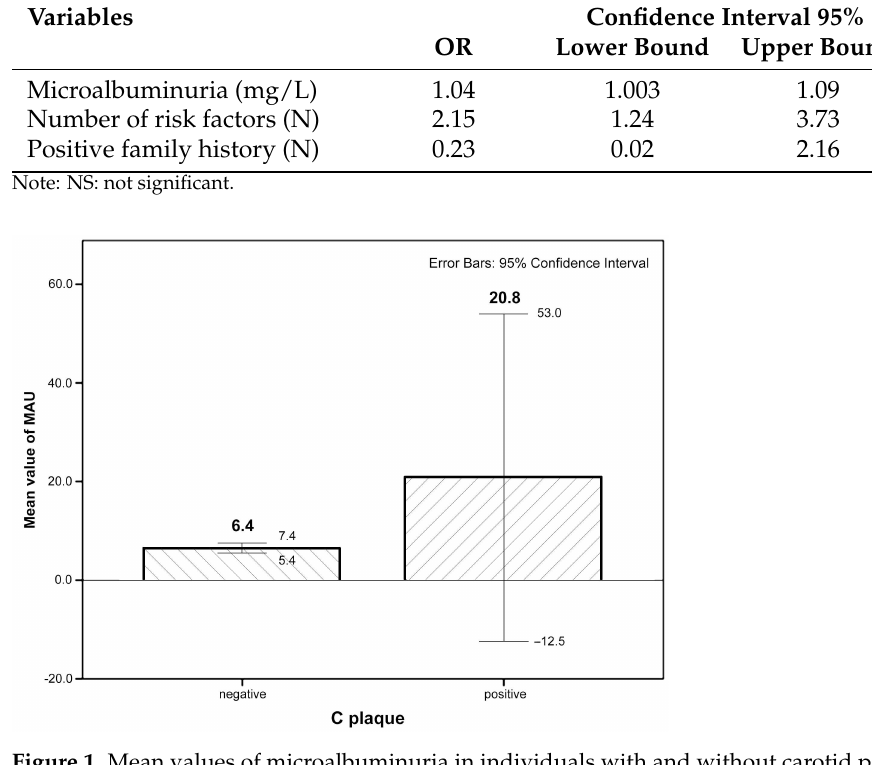
Figure 1. Mean values of microalbuminuria in individuals with and without carotid plaque. Note: data are shown as mean values of microalbuminuria (in mg/L) ± standard deviation; 95% confidence interval for individuals with absence (negative: 6.44 ±6.69 mg/L; 95% CI 5.44–7.44) or presence of